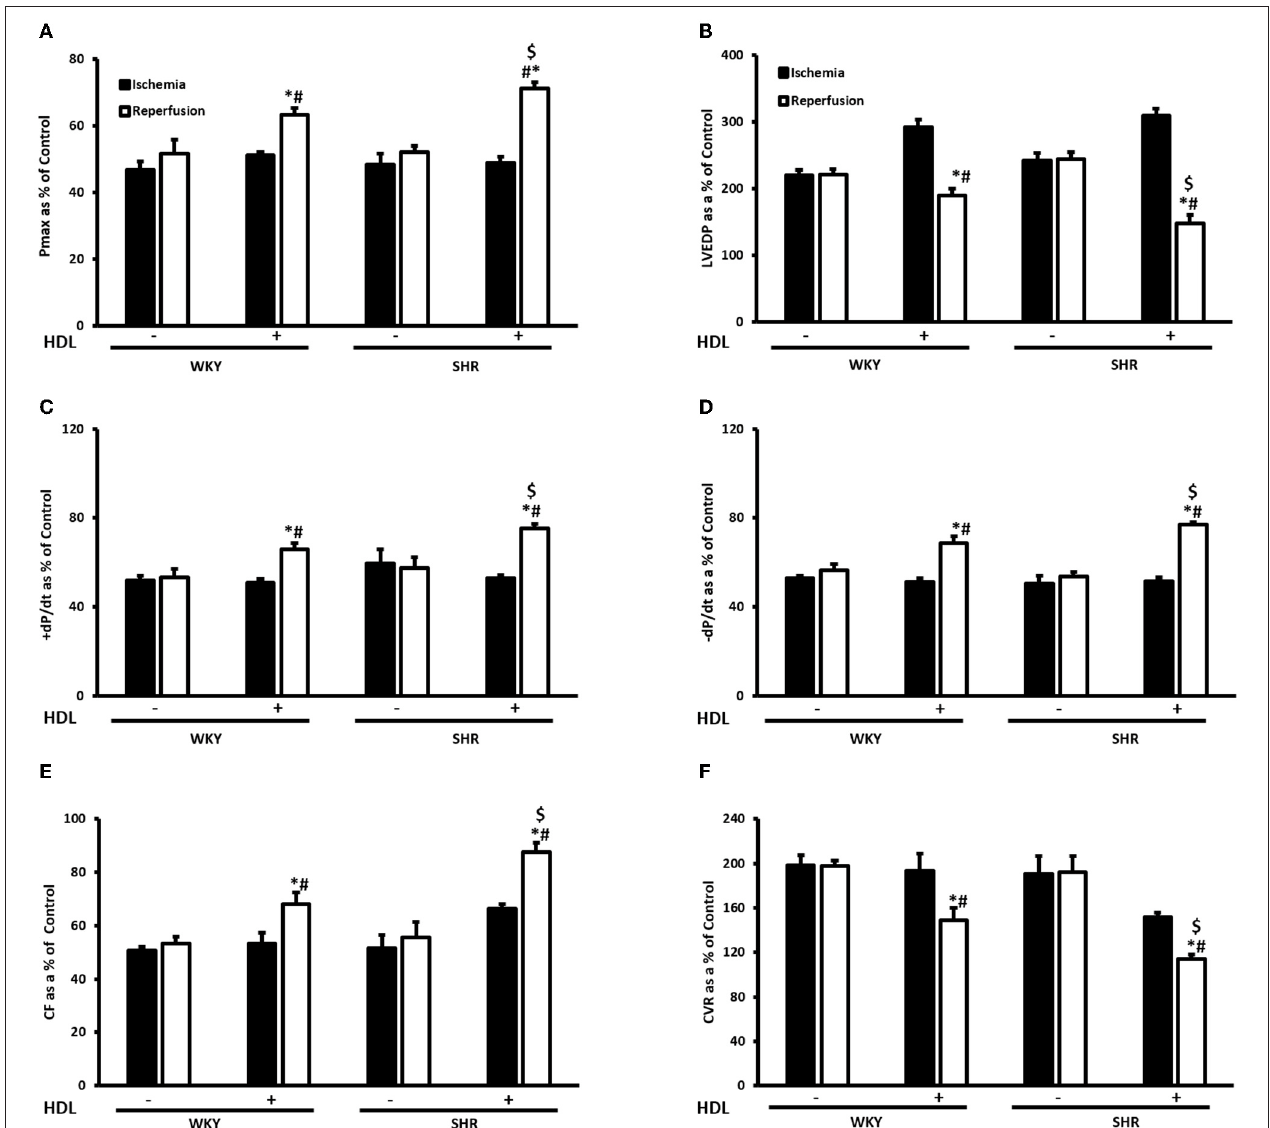
FIGURE 3 | Effect of chronic HDL treatment on I/R injury in WKY and SHR. Post-ischemic recovery parameters of cardiac functions including DPmax (A) , LVEDP (B) , cardiac contractility (C,D) , CF (E) , and CVR (F) . Data were computed at 30min of reperfusion and expressed as means ± SEM. DPmax, maximum developed pressure; LVEDP, left ventricular end diastolic pressure; CF, coronary flow; CVR, coronary vascular resistance. * P < 0.5 compared to ischemic period, # P < 0.5 compared to control pump, $ P < 0.05 vs. HDL treated WKY, n = 6–10 rats per